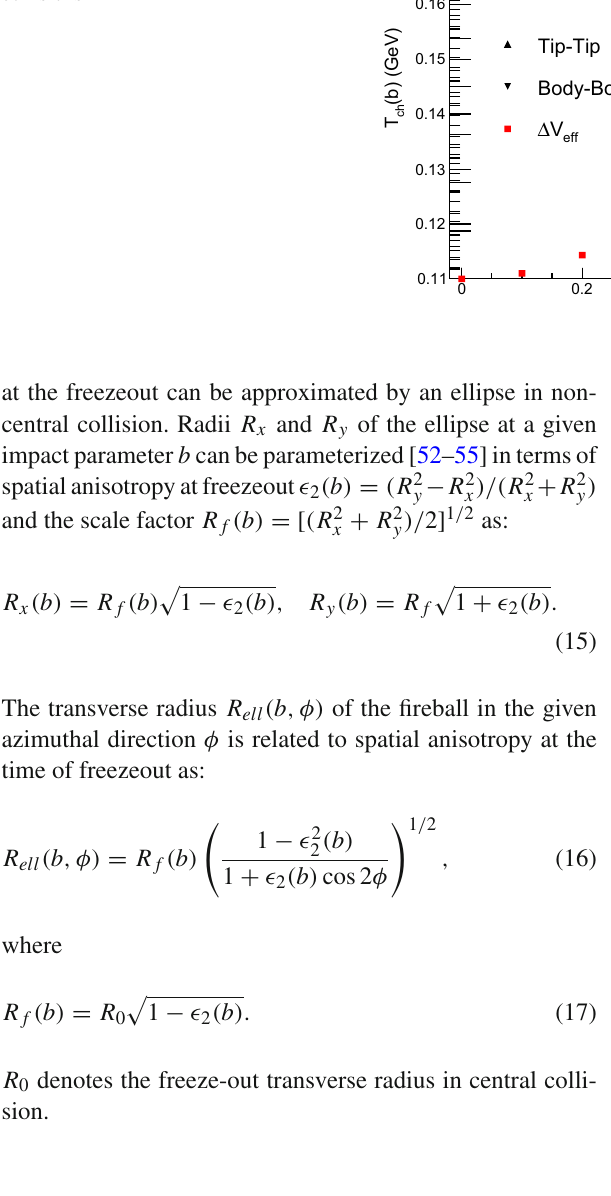
Fig. 6 Variation of T ch ( b ) and (cid:11) V ef f with impact parameter for tip–tip and body–body